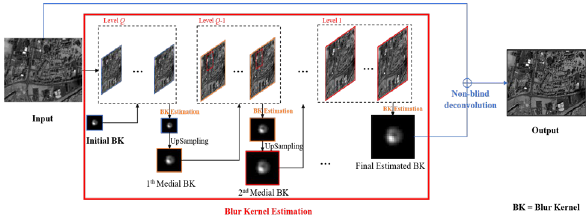
Figure 2. Flowchart of the proposed CPMMP prior regularization method for deblurring.